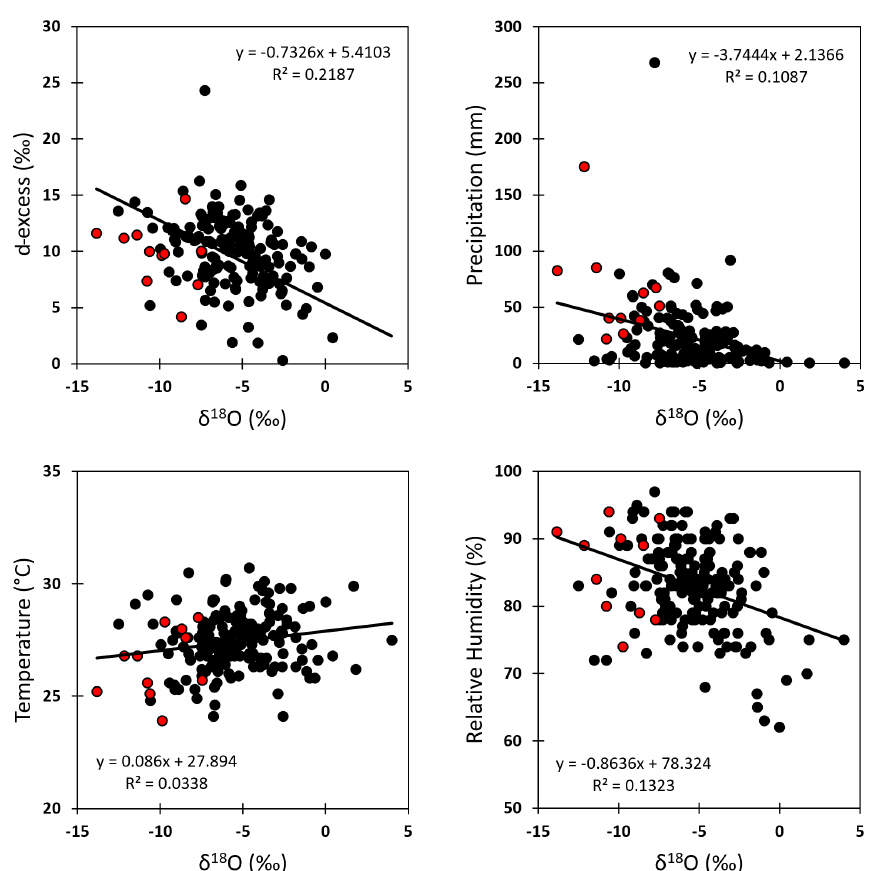
Figure 4. Correlations between daily δ 18 O values and daily values of d-excess, precipitation amount, temperature, and relative humidity. Linear regression line, correlation coefficient ( R 2 ), slope, and intercept are shown in each plot. Samples associated with a TC are shown in red similar to Fig. 5.